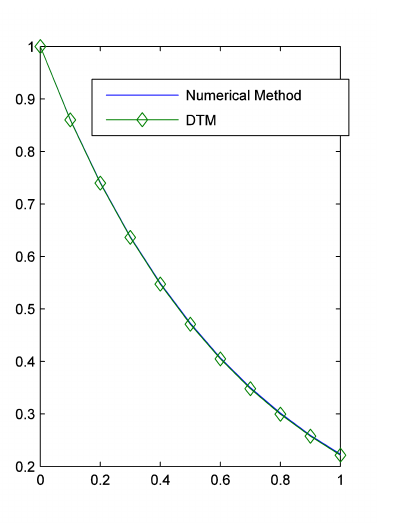
Fig. 3: Comparison of temperature profile with RK4 and 20 th order DTM-Padè solution